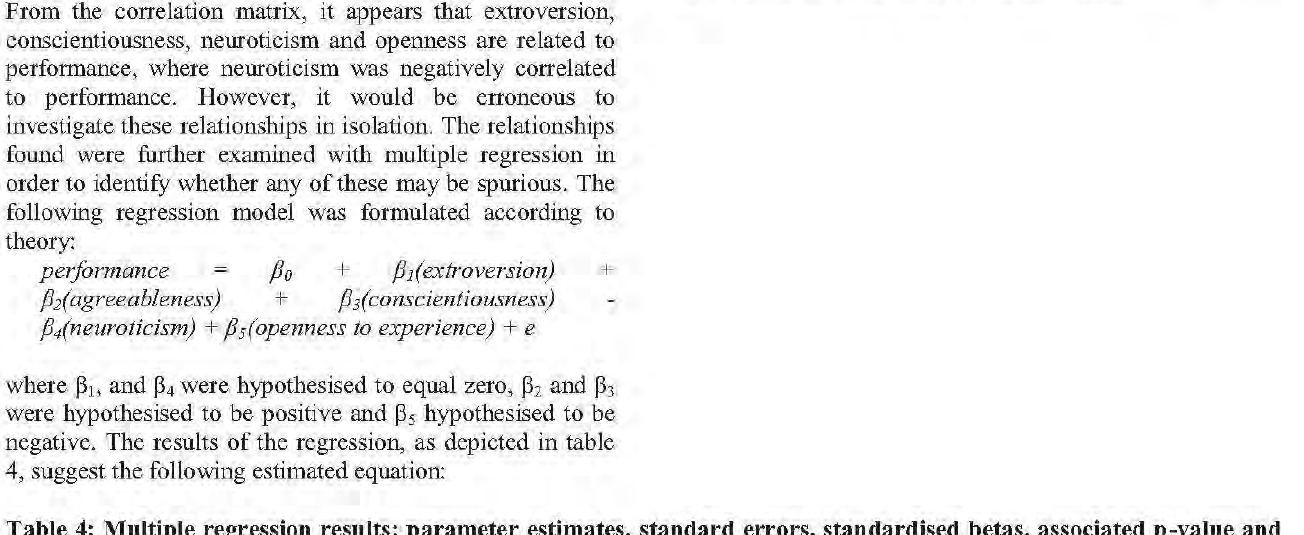
Table 4: Multiple regression results: parameter estimates, standard errors, standardised betas, associated p-value